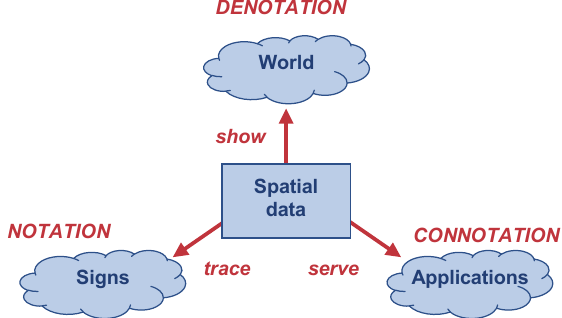
Figure 1. Notation, Denotation and